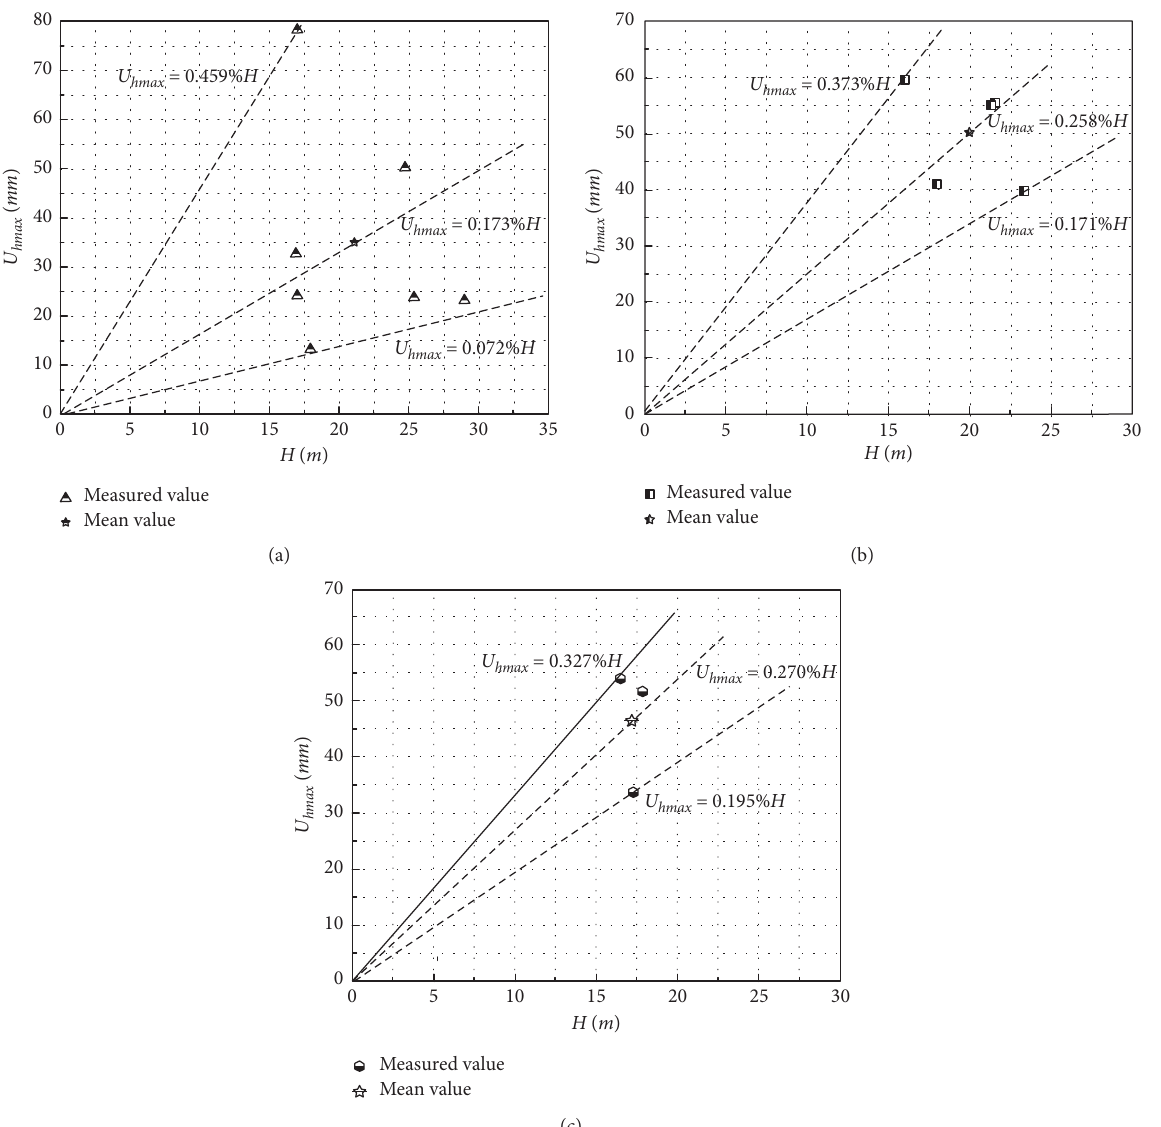
Figure 6: Relationship between the depth of the foundation pit and the maximum lateral deformation of the wall. (a) Hangzhou. (b) Shanghai. (c)